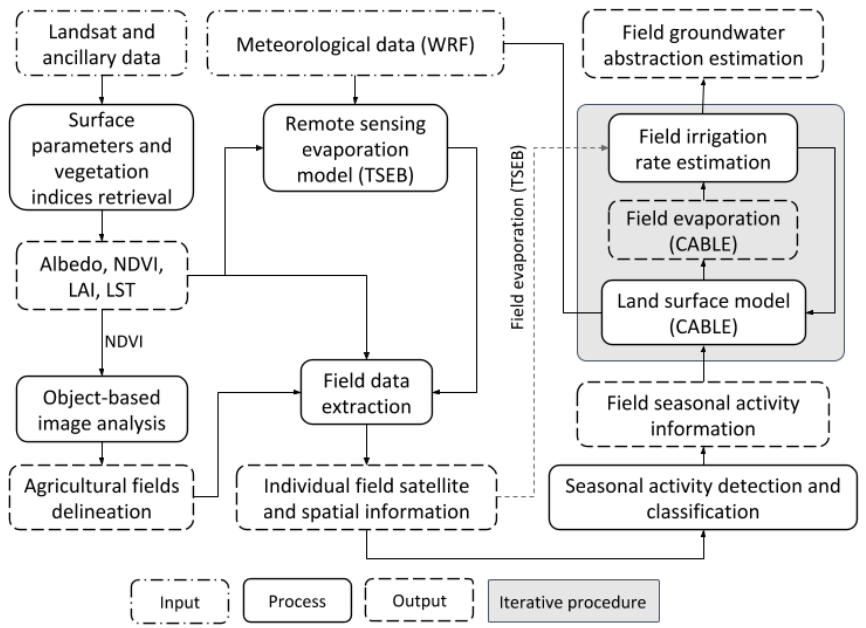
Figure 2. Flow chart outlining the main inputs (dashed-dotted), processes (solid), and outputs (dashed) of the groundwater abstraction monitoring